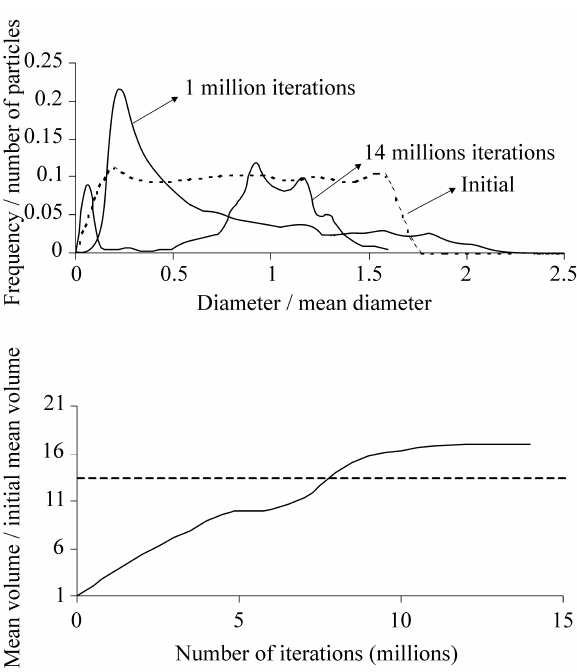
Figure 4. The result of action of w